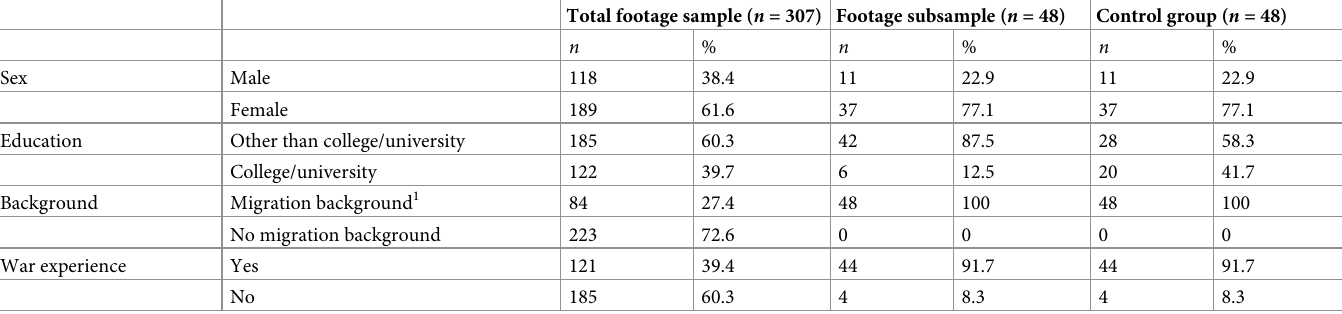
Table 1. Demographic characteristics of participants in